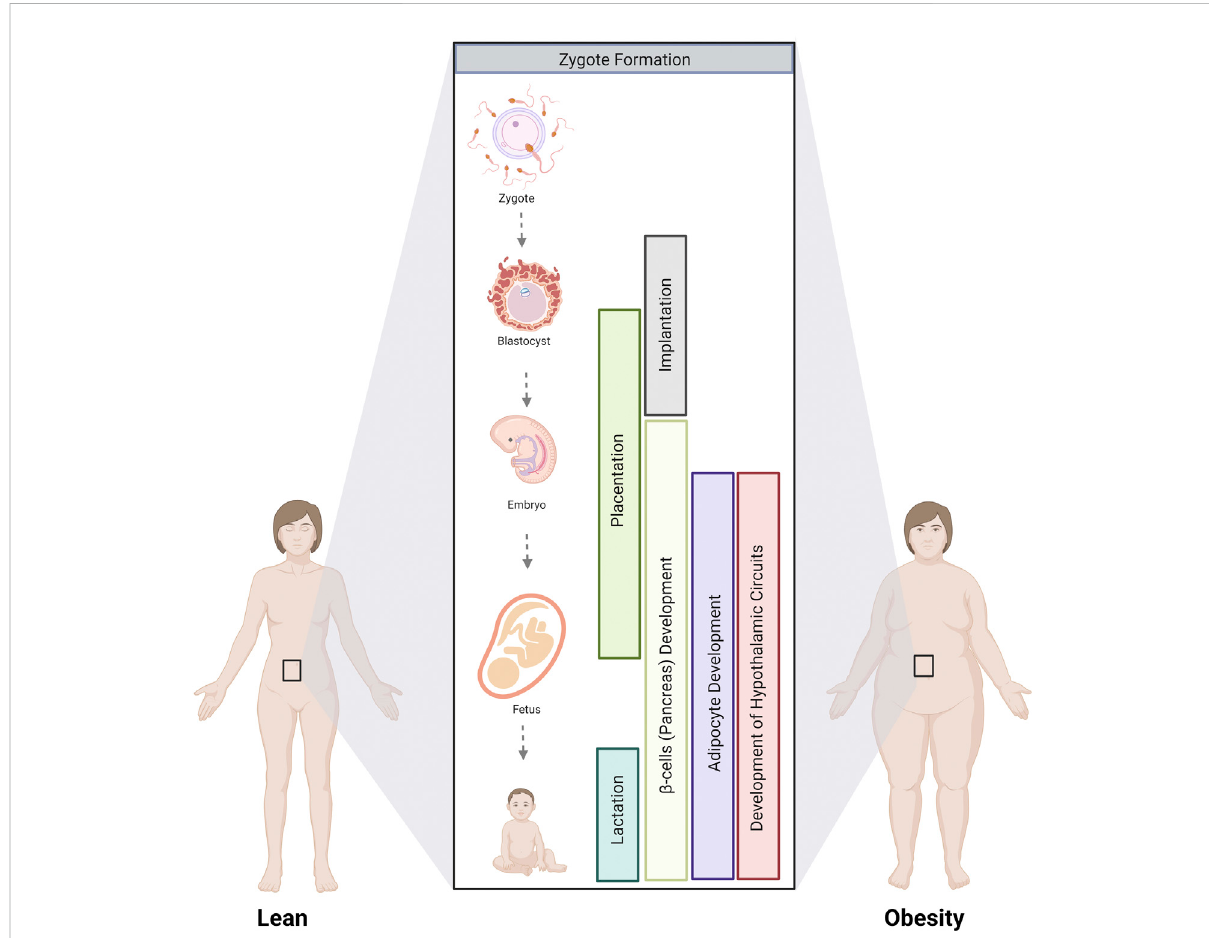
FIGURE 5 Critical stages where parental obesity in fl uences developmental programming. The development of multiple tissues and organs involved in metabolism is altered by parental obesity from gamete formation until lactation. Critical stages involve gamete formation, placentation, and the development of adipocytes, the pancreas, and the hypothalamic circuits that control appetite that occurs during fetal and postnatal